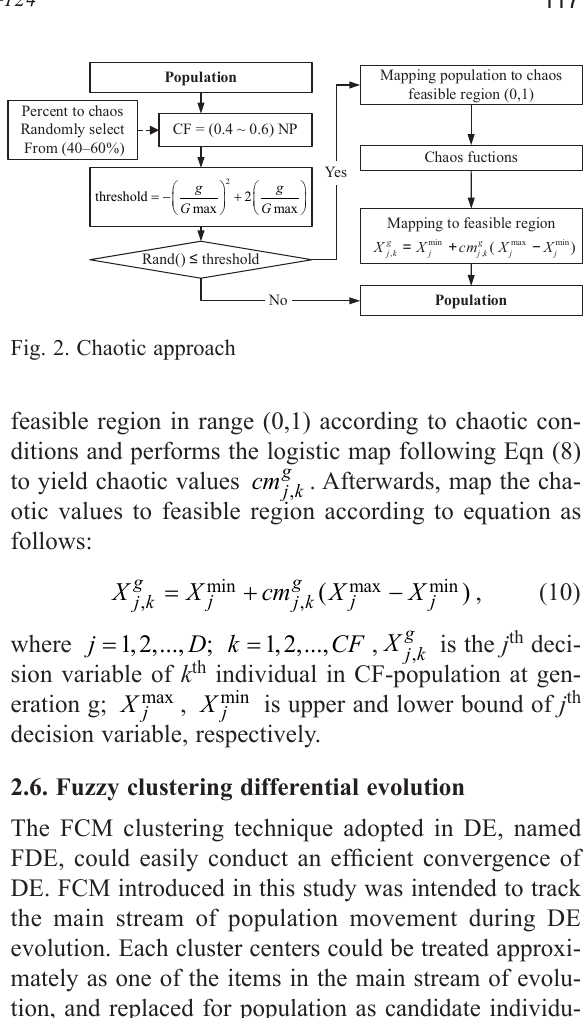
Generate randomly k from [2,sqrt (NP )] (SetB)Choose randomly kpar ents (SetA ) from population P Adopt the fuzzy c-means clustering to create k centroid points